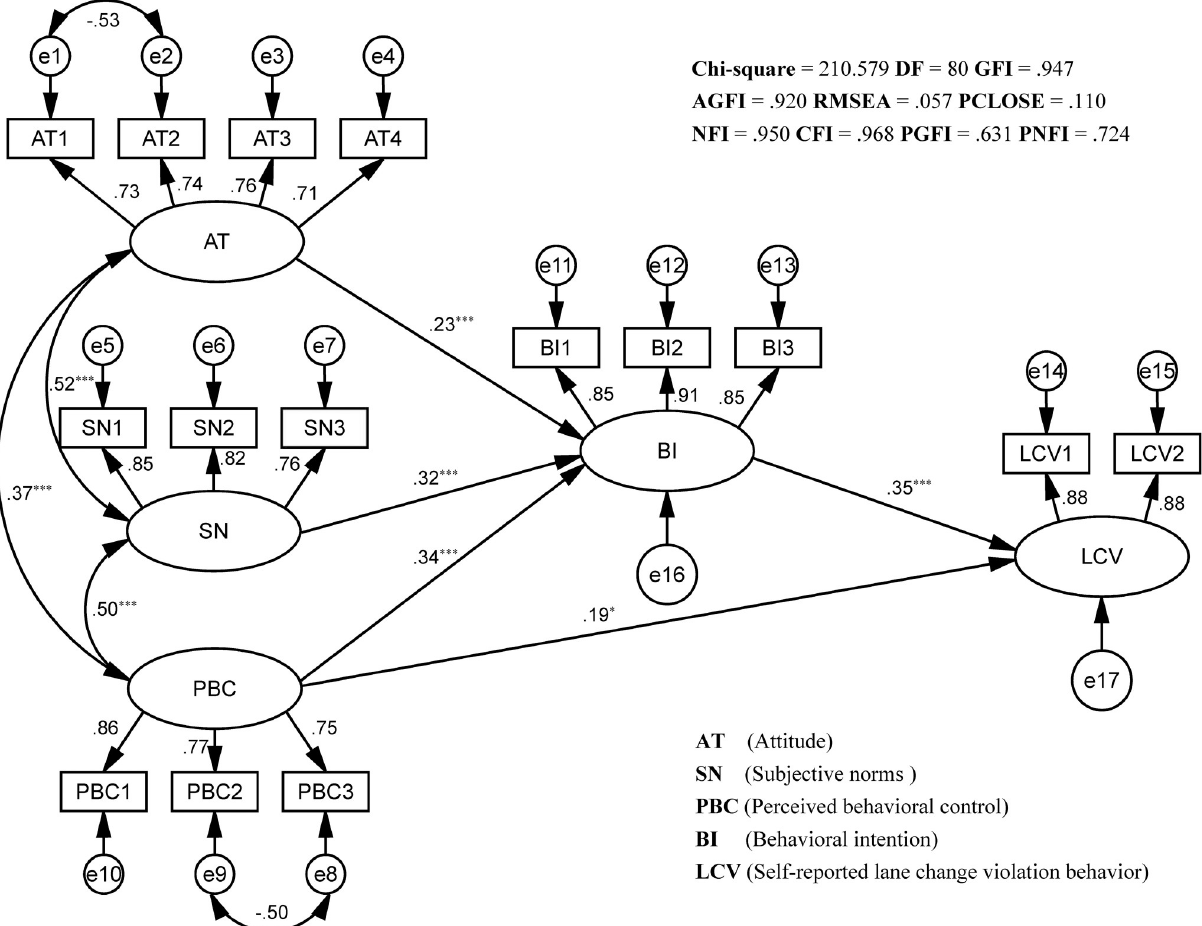
Fig 3. Structural model test results. All paths represent significant standardized regression weights (Std.R.W.). The structural model fit indices shown at the top satisfy all acceptable criteria, indicating an optimal goodness-of-fit path relationship of the structural model. � p � 0.05, ��� p �